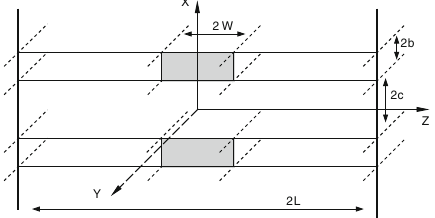
Fig. 53 Sketch of a multi-thread equilibrium configuration. The grey zone represents the cold part of the magnetic tube, i.e., the prominence. The magnetic field is uniform and parallel to the z -axis, and the whole configuration is invariant in the y -direction. Image reproduced with permission from Díaz et al. (2005), copyright by ESO